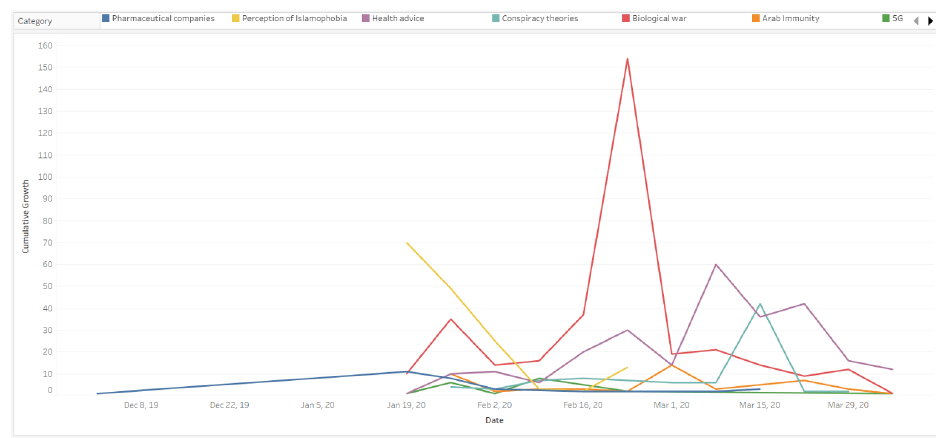
Figure 3. Cumulative Weekly Growth of